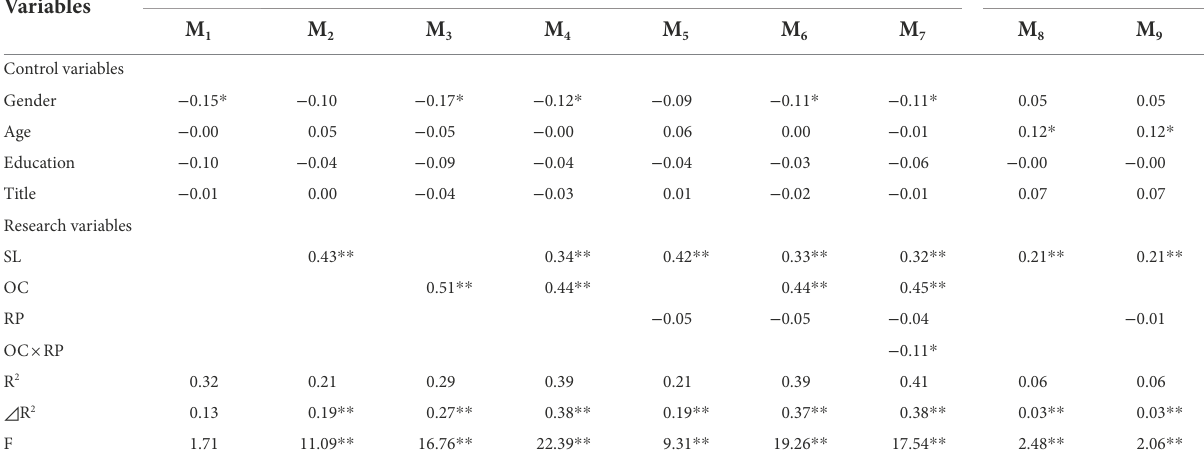
TABLE 2 Results of hierarchical regression analysis.